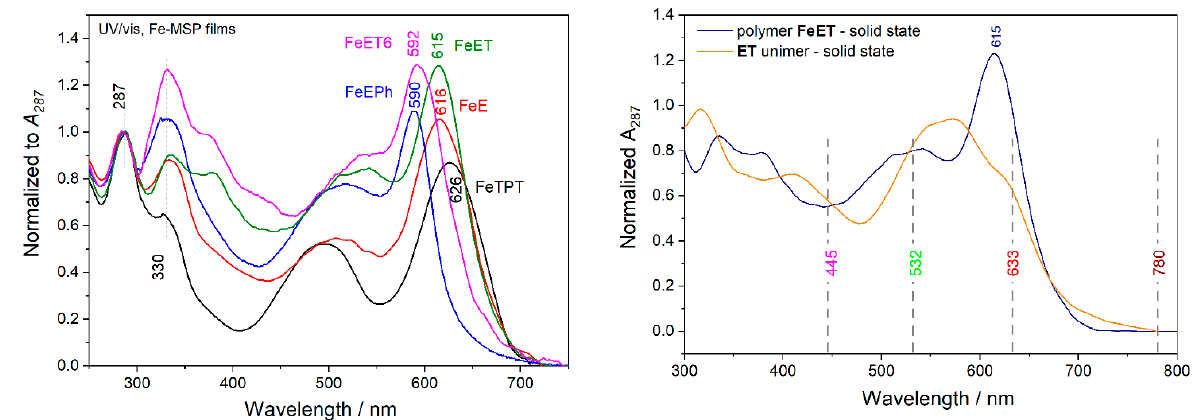
Figure 3. ( Left ): UV/vis spectra of Fe-MSP films. ( Right ): UV/vis spectra of films of the ET unimer